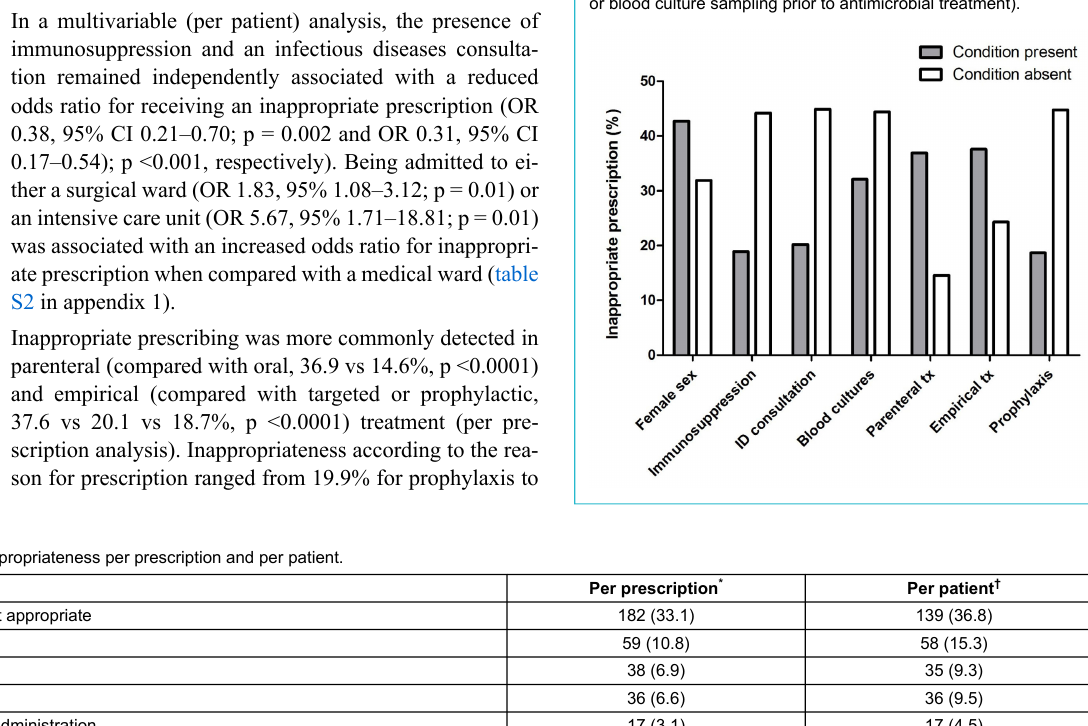
Figure 1: Inappropriateness of antimicrobial prescriptions accord- ing to the presence or absence of patient characteristics (n = 378; female vs male sex; immunosuppression) and prescribing charac- teristics (n = 548; parenteral vs oral and empirical vs targeted/pro- phylactic treatment; prophylaxis vs other indications for antimicro- bials) or procedures (n = 378; infectious diseases (ID) consultation or blood culture sampling prior to antimicrobial treatment).